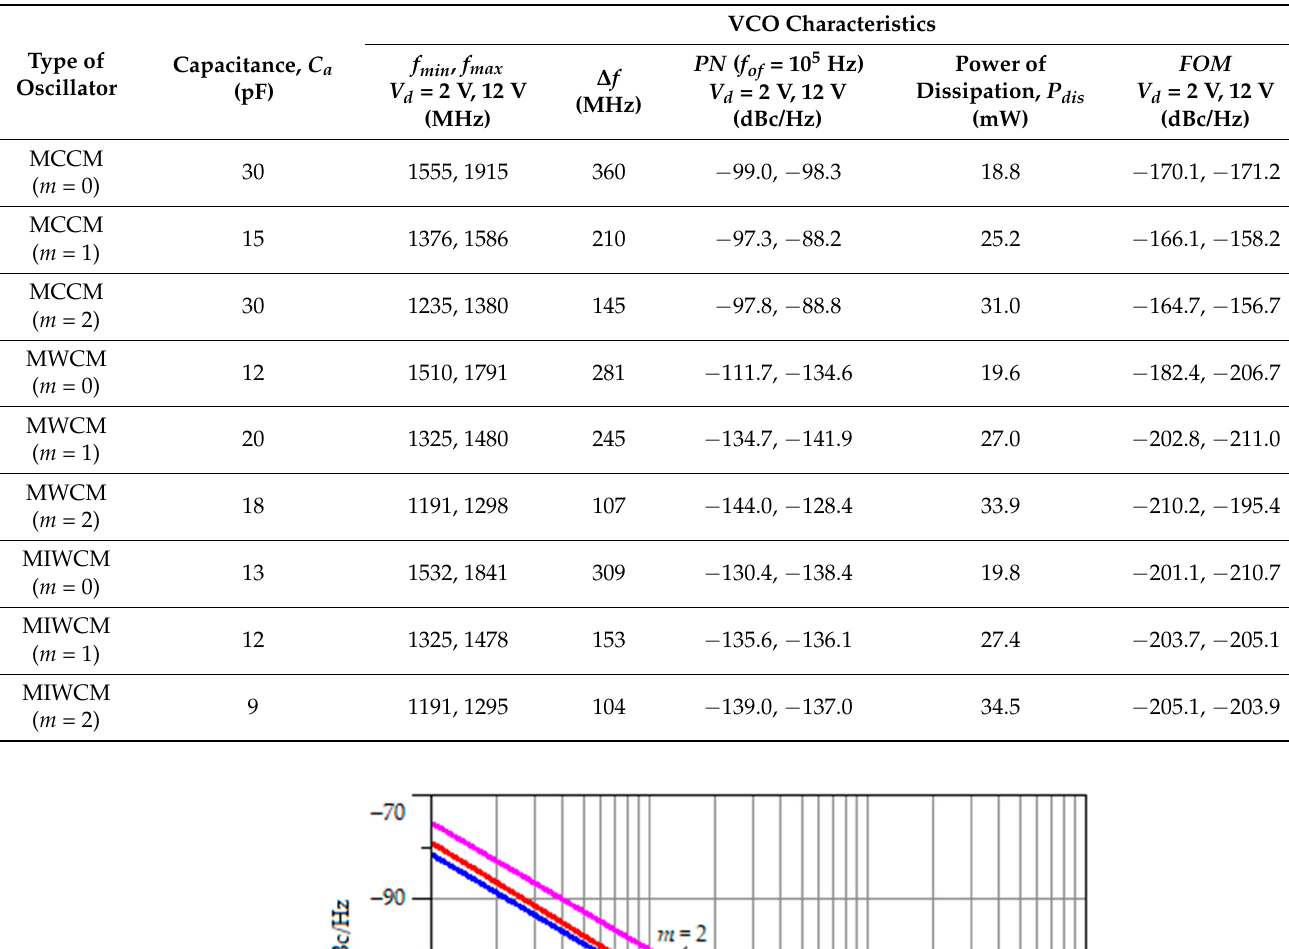
Table 12. Simulated characteristics of different NDR VCOs when R L = 50 Ω .